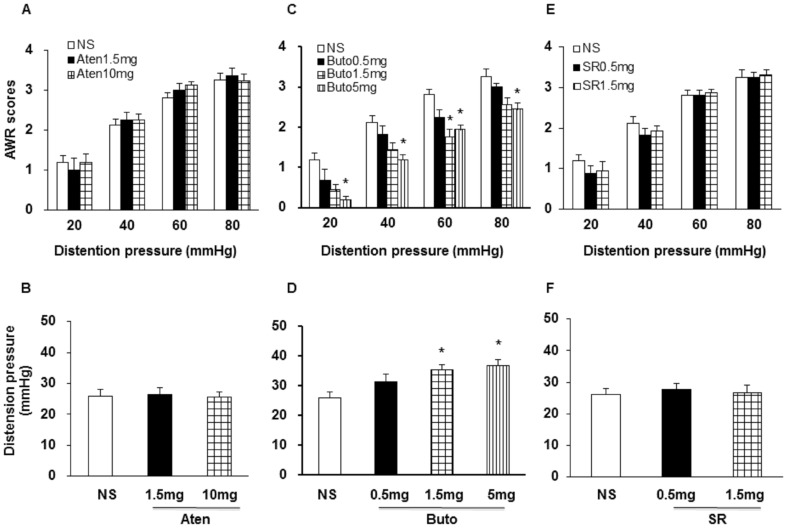
Administration of β2-adrenoceptor antagonist attenuated AWR scores in HIS rats.(A, B) The β1-adrenoceptor antagonist Atenolol (1.5, 10 mg/kg) had no visible effect on AWR scores and distension threshold. (C, D) The β2-adrenoceptor antagonist Butoxamine (0.5, 1.5 and 5 mg/kg) largely blocked visceral hyperalgesia induced by HIS in a dose-dependent manner, the maximal effect was observed at 5 mg/kg, *p<0.05 vs. NS. (E, F) The β3-adrenoceptor antagonist SR_59230A (0.5 and 1.5 mg/kg) had no visible effect on the visceral hypersensitivity induced by HIS. NS: normal saline; Buto: Aten: Atenolol; Butoxamine; SR: SR_59230A.